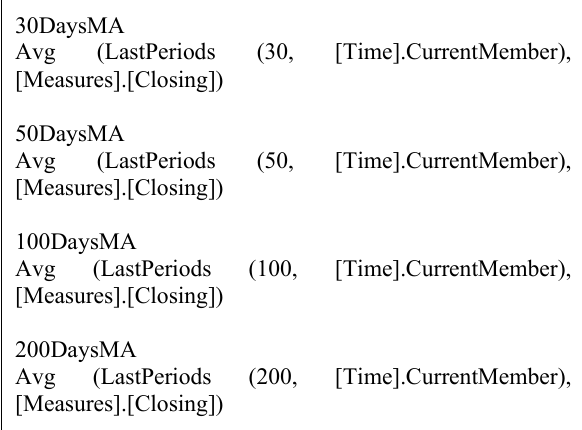
Figure 2: KSE100 MA KSE100 - SLR Model